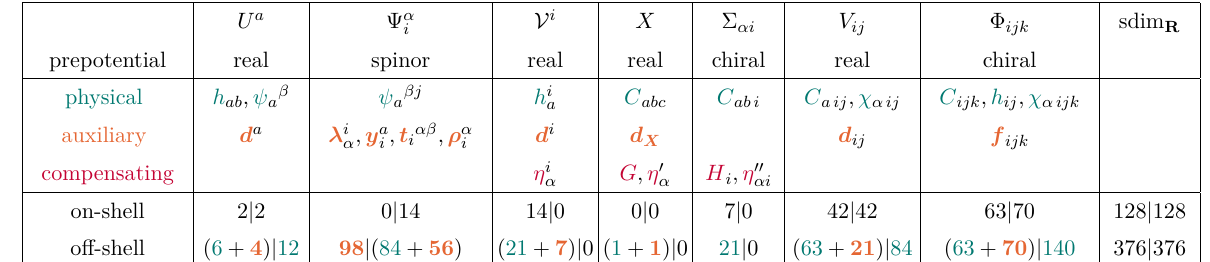
and χ (2.5). The real superdimension αij αijk